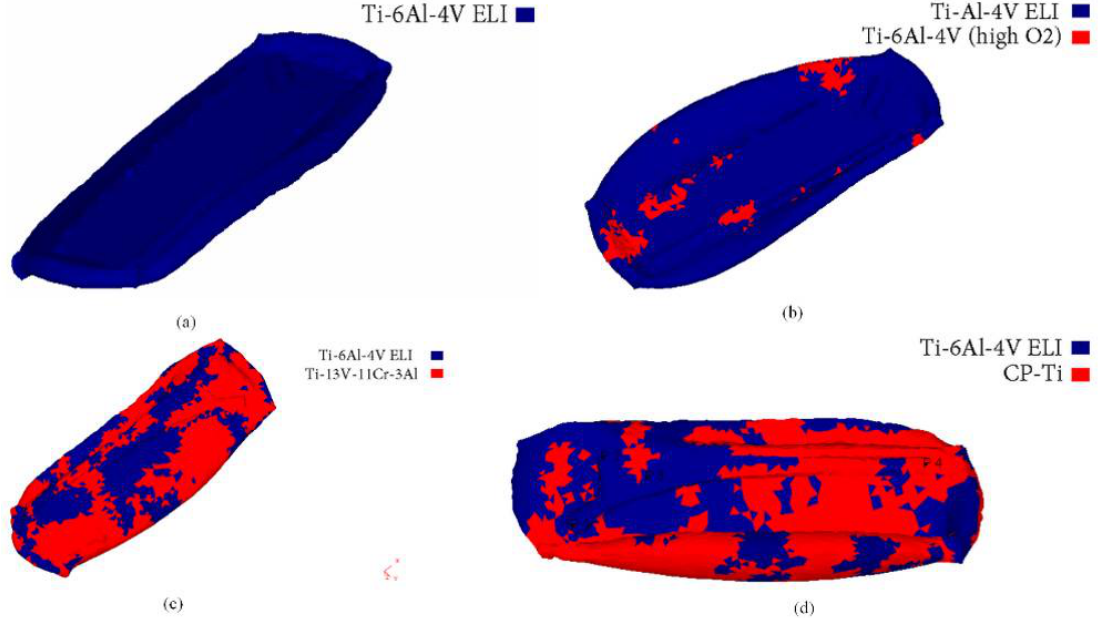
Figure 5. Three-dimensional view of partitioned forging of ( a ) Part 1, ( b ) Part 2, ( c ) Part 3 and ( d ) Part 4. ( d ) Part